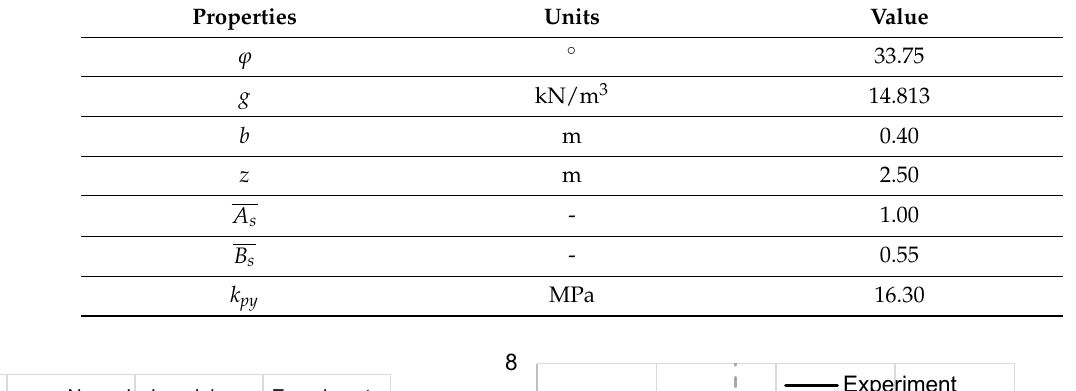
Figure 6. Numerical model of the SSI case ( a ) and force-displacement curve for the soil links ( b ). Table 4. Soil properties for definition of P-y curve.